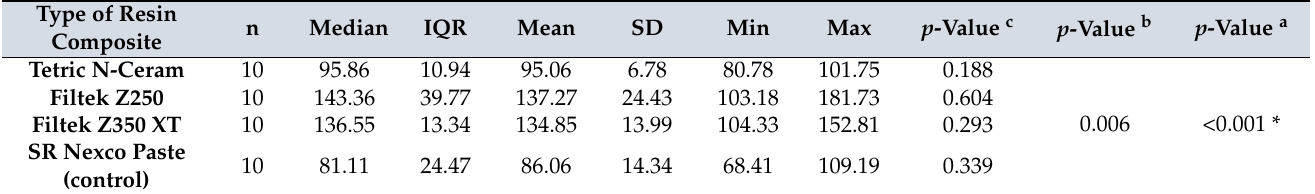
Table 4. Comparison of microflexural strength with additional dry heat curing, according to the type of resin composite.